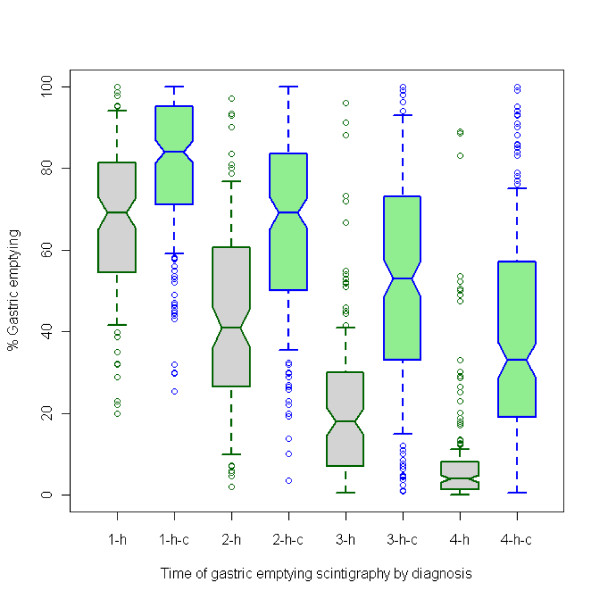
Percent gastric retention at 1-h, 2-h, 3-h, and 4-h after meal for case (green) vs. control (grey). 1-h-c, 2-h-c, 3-h-c, 4-h-c represents percent gastric emptying (GE) at 1-h, 2-h, 3-h, and 4-h after meal for patients diagnosed with gastroparesis; Whisker represents 70% interquartile range.